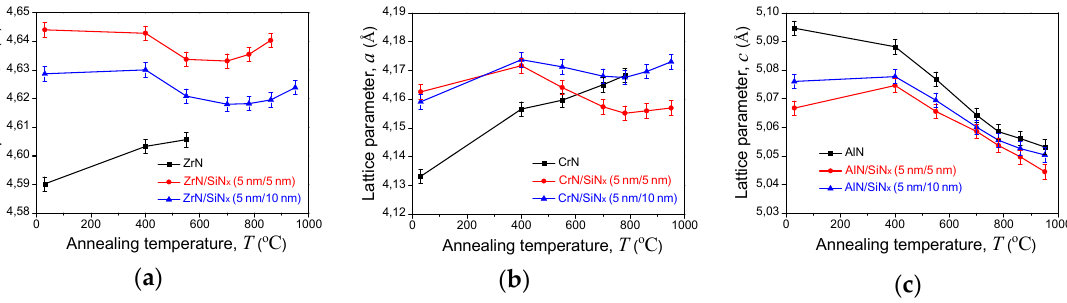
Figure 7. Dependences of the lattice parameter of MeN phase on the annealing temperature for multilayered films with comparison with the same dependences for reference monolithic films: ZrN/SiN x ( a ); CrN/SiN x ( b ); and AlN/SiN x ( c ).